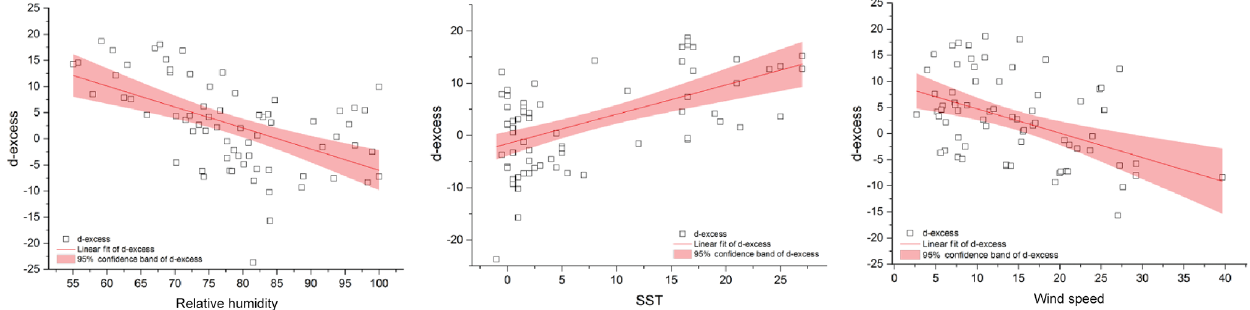
Figure 6. Regression plots for d-excess (hollow black squares) in water vapor and the meteorological conditions (relative humidity, sea surface temperature and wind speed). The shaded region depicts the 95% confidence bands of d-excess. The slope and intercept of the regression equations along with data from Uemura et al. (2008) are listed in Table